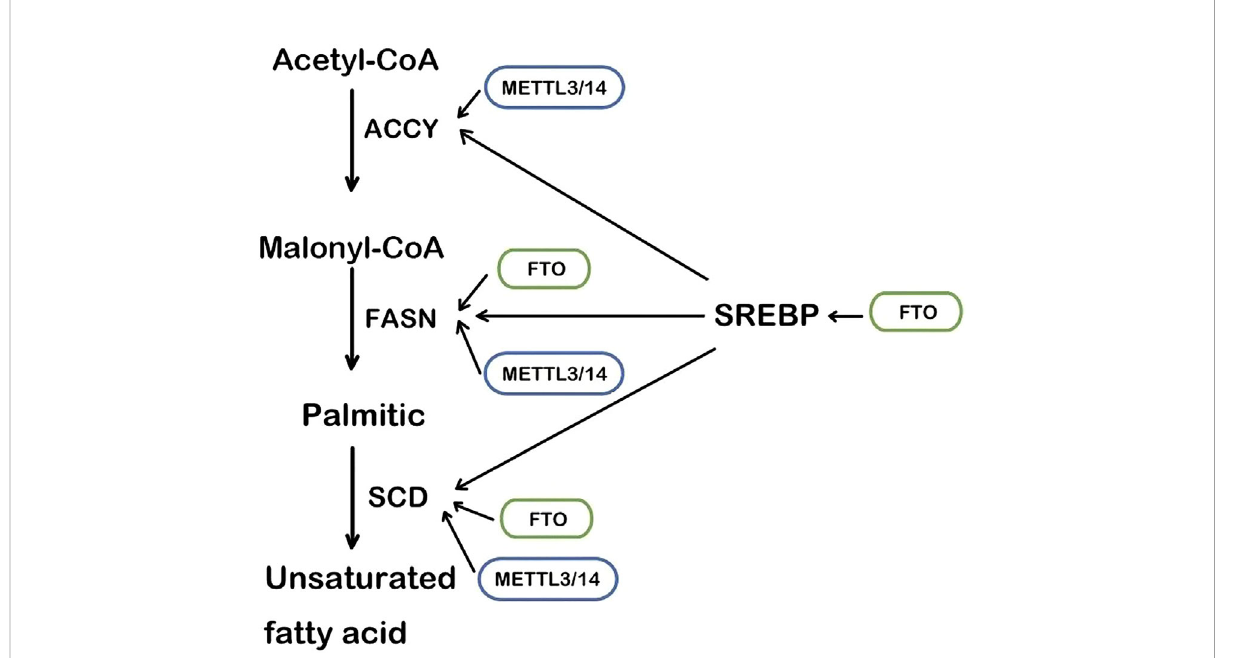
FIGURE 1 The main steps of lipogenesis and the regulation of FTO and METTL3/14. SREBP, sterol regulatory element-binding protein; FASN, fatty acid synthase; ACCY, acetyl-CoA carboxylase; SCD, stearoyl-CoA